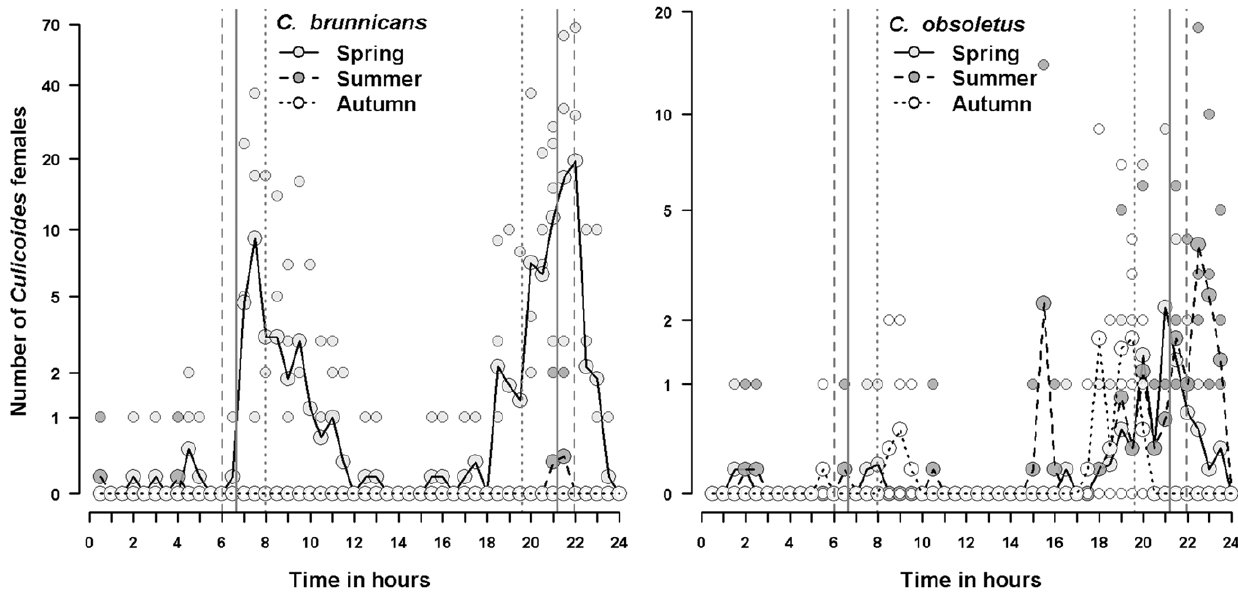
Figure 4. Correlation between the numbers of C.brunnicans and C.obsoletus collected outdoor in host-baited traps and in UV-light/ suction trap.